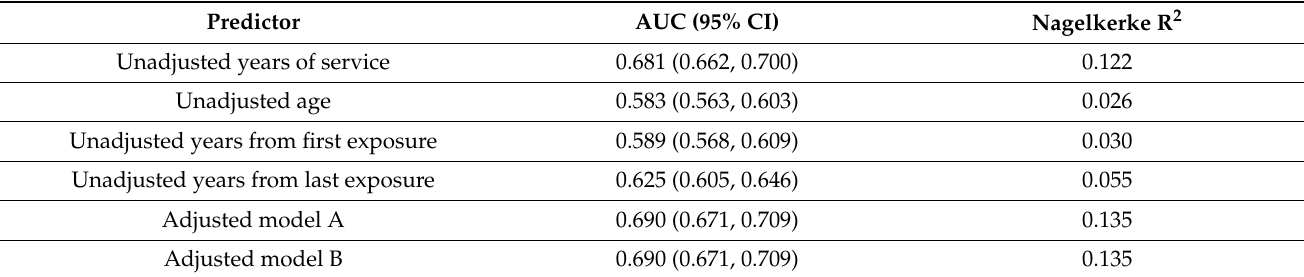
Table 5. Area under the curve (AUC) of different predictive models.